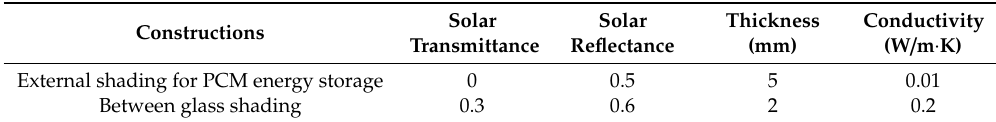
Table 4. Shading properties.